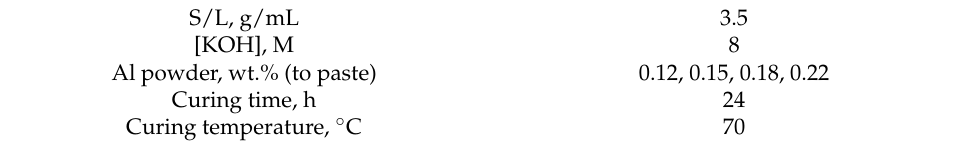
Table 4. Experimental conditions of geopolymer foams with different % Al powder addition.